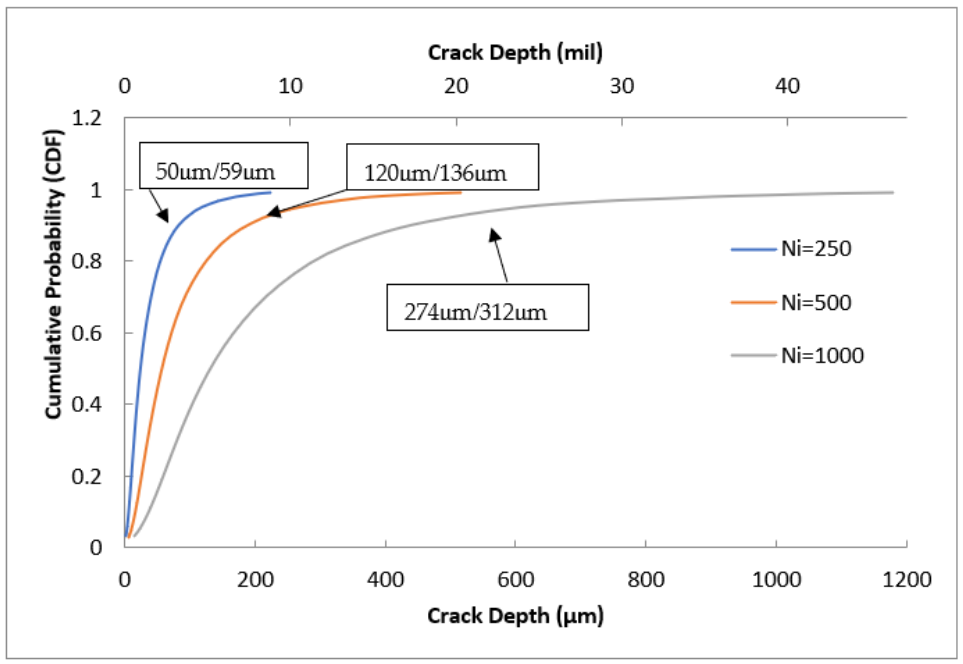
Figure 12. Cumulative distribution function for three initiation lives (N i ) the mean and standard deviation (m/stdev).